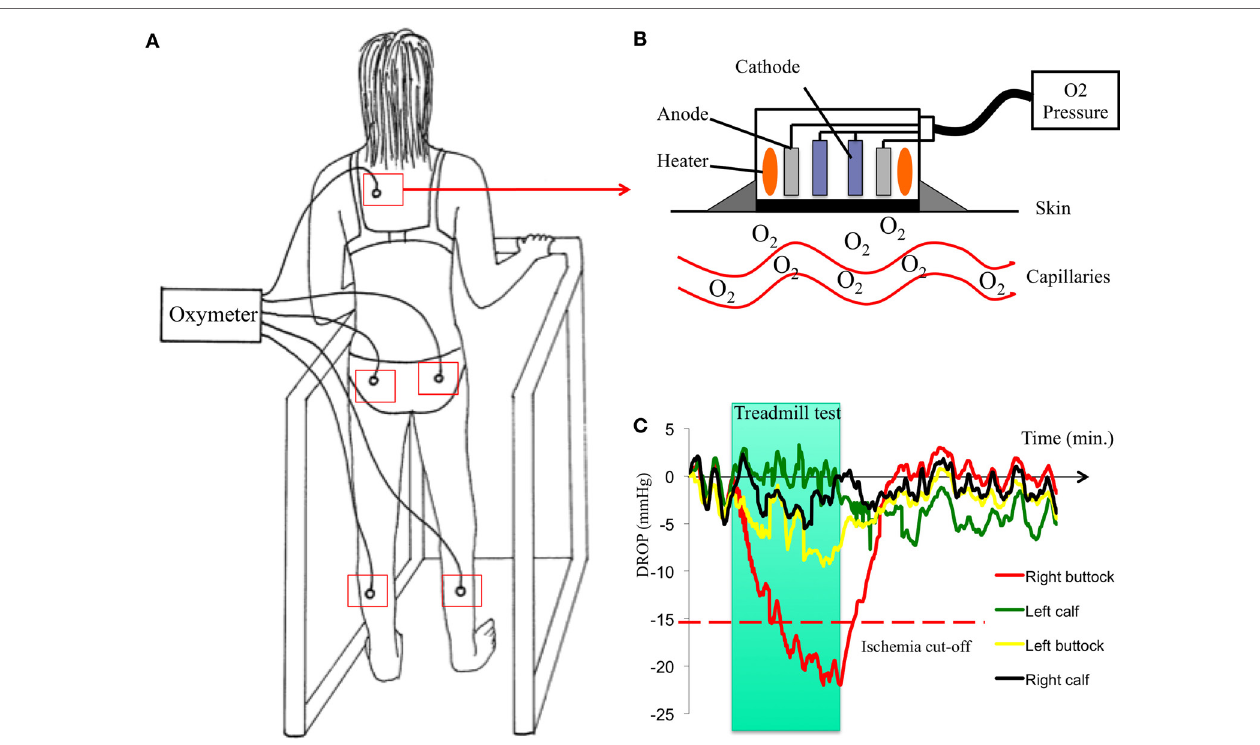
perform her job. She has a normal right femoral pulse and normal ankle-brachial index. (A) : patient on a treadmill with five probes of TcPO 2 (one on each buttock, one on each calf, and one on the chest) and a 12-lead electrocardiogram. Upper right (B) : schema of a TcPO 2 probe. Lower right (C) : typical recordings of Exercise-TcPO 2 measurements showing a right buttock ischemia with a DROP (delta from rest of oxygen pressure) lower than − 15 mm